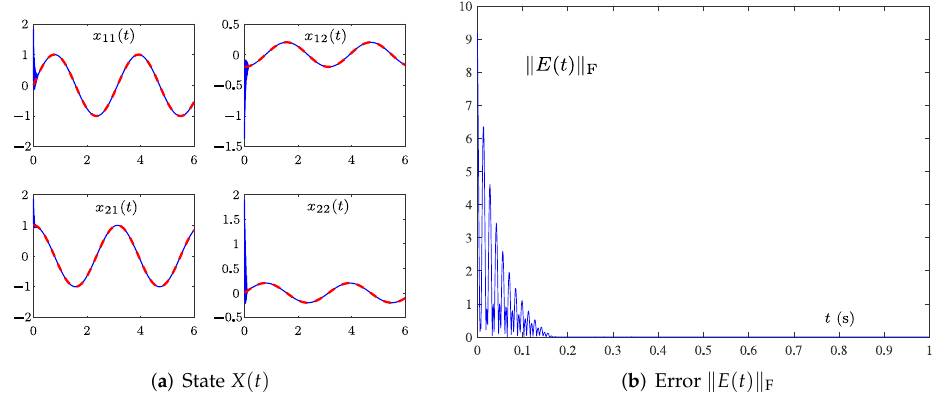
Figure 5. Simulation results by the PTCAZNN model (15) with λ = 10 for TVMIP of (40) under the same single-harmonic noise when f = 50 Hz.